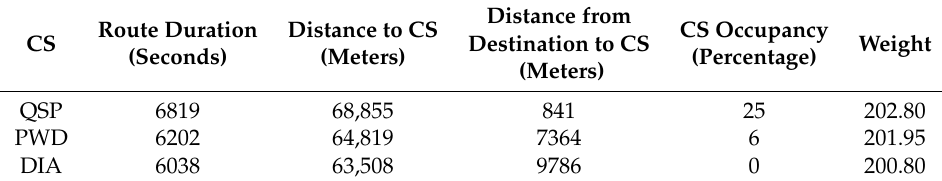
Table 4. Navigate option with Broughty Ferry as the destination.